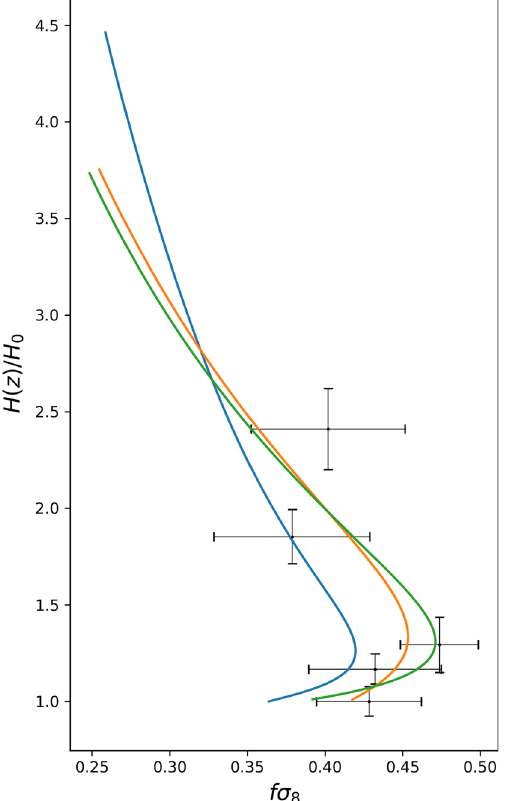
Fig. 12 Goodness of fit test for binned data, from Table 3. The blue curve corresponds to Λ CDM, the orange one to the Starobinsky n = 1 model with the best-fit parameter λ , and the green one with the best-fit parameter for n = 2, both found from the minimization of Eq. (32) in the MCMC analyses